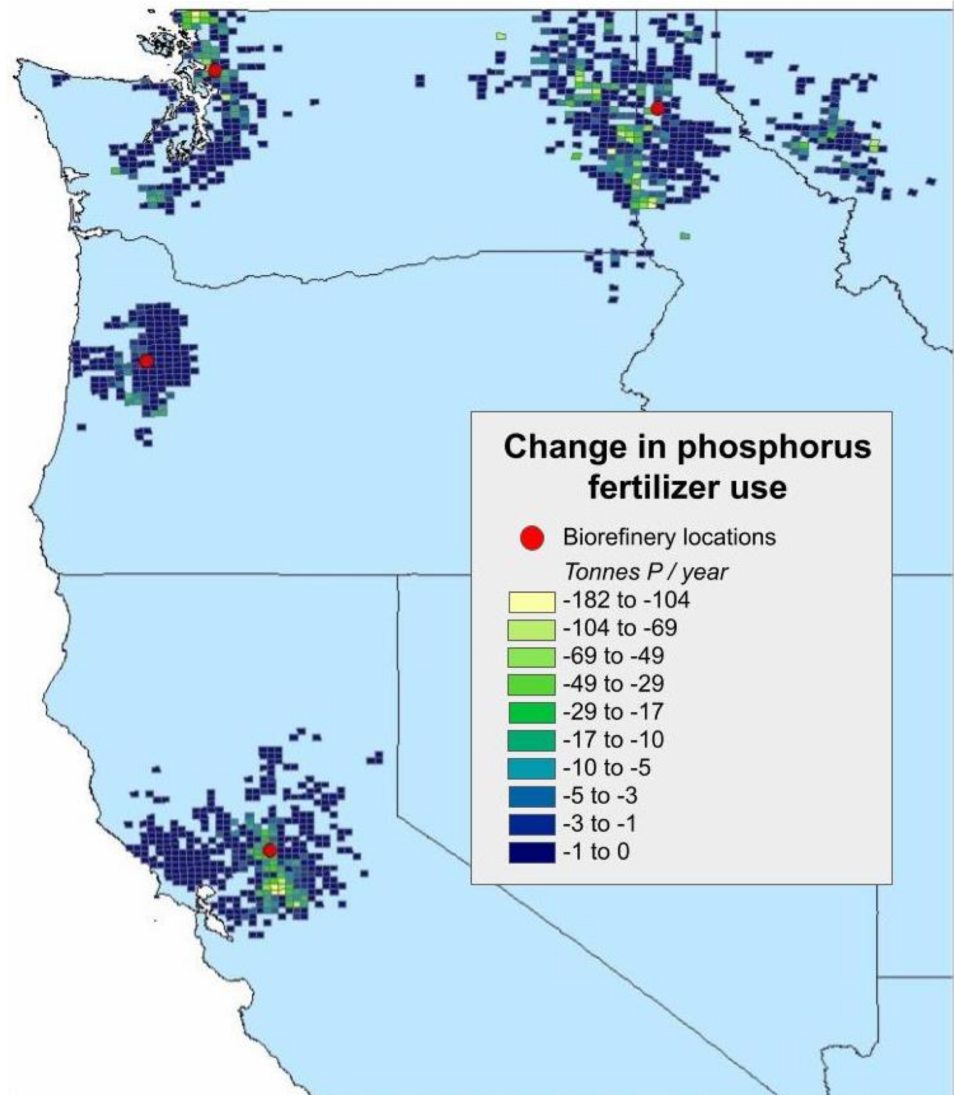
Figure 3. Change in phosphorus fertilizer use for each pixel as a result of switching from current practices to growing poplar trees for bio-jet fuel production. Phosphorus fertilizer is not expected to be used to grow poplar trees, and therefore all pixels would see a decrease in use. Pixels that contain crops where phosphorus fertilizer is used would see the greatest reduction in use (light blue/green to yellow). Pixels that predominantly contain rangeland that would be converted would see very little reduction in phosphorus use (dark